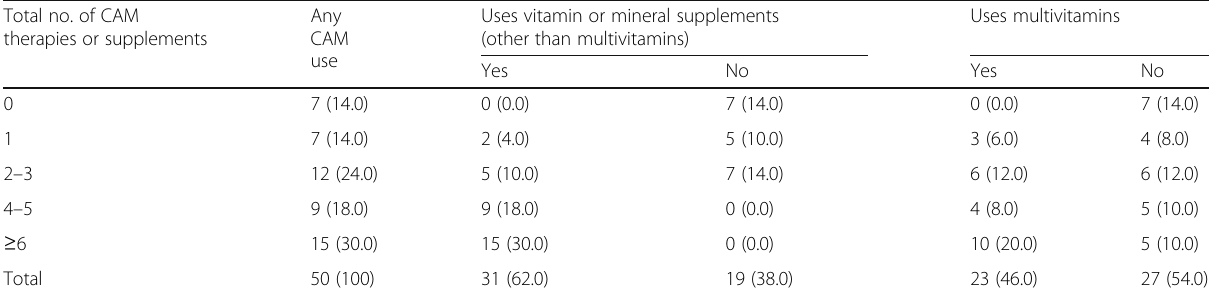
Table 3 Number of CAM therapies or supplements by multivitamin and other vitamin or mineral supplement use Total no. of CAM therapies or supplements